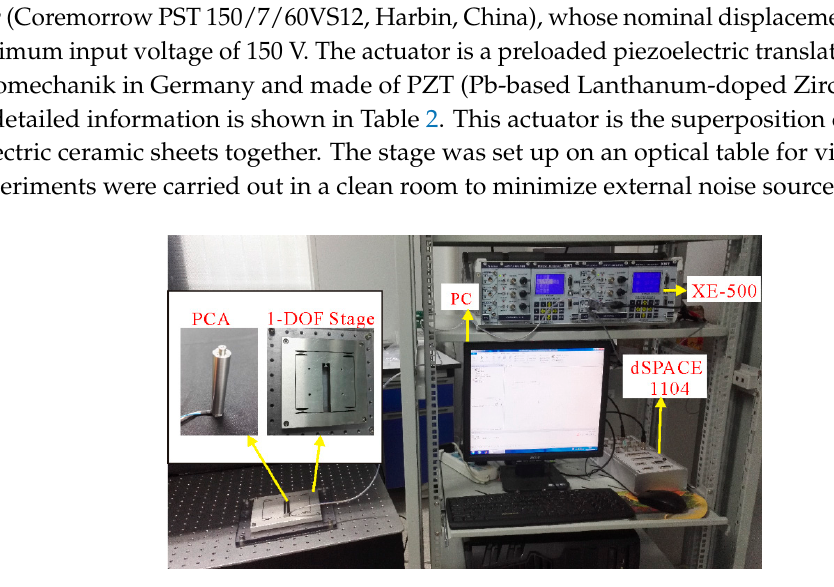
Figure 6. Generalized Bouc–Wen (GB–W) model implemented with MATLAB/Simulink.